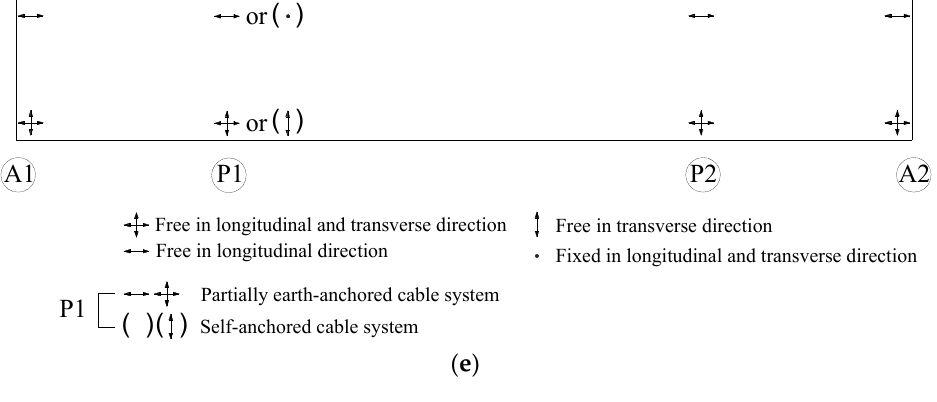
Figure 4. Outline of the sample bridge (units: m). ( a ) Side view; ( b ) Cross ‐ section of the girder; ( c ) Pylon; ( d ) Cross ‐ sections of the pylon; ( e ) Bearing conditions.